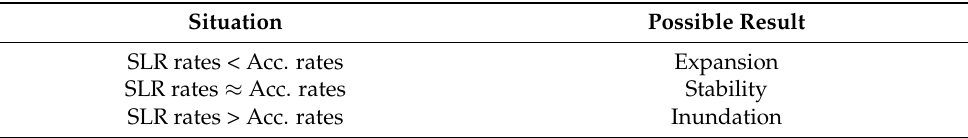
Table 1. Possible results for the evolution of salt marsh areas, considering the balance between SLR rates and accretion (Acc.) rates.